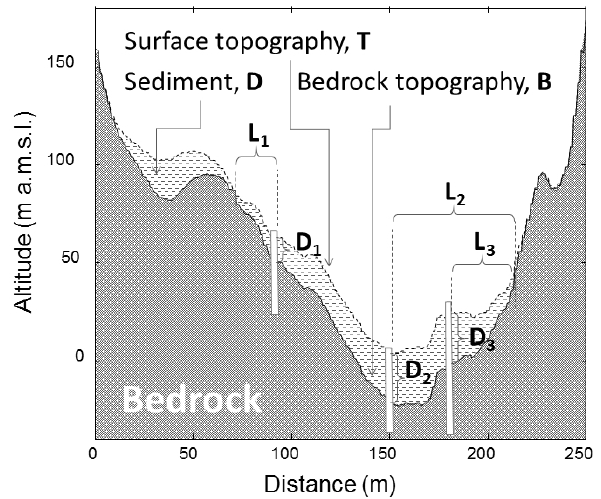
Figure 1. Surface topography T , sediment thickness D , and bedrock topography B . Observations of D i are indicated in three boreholes ( i = 1 , 2 , 3) and with the associated horizontal distance to the nearest outcrop ( L i ). In areas where B is not exposed, B can be estimated by using observations of D as the primary variable and information of L as secondary